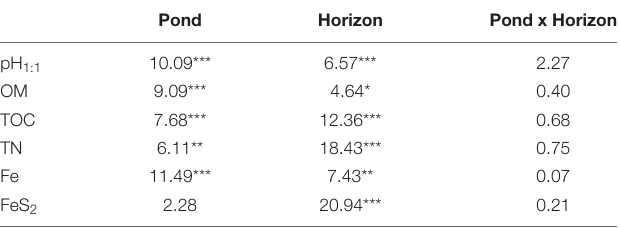
Significant results are indicated by asterisks (*p < 0.05; **p < 0.01; ***p < 0.001); OM, organic matter; TOC, total organic carbon; TN, total nitrogen, Fe, iron; CRS, chromium reducible sulfur (FeS 2 ).